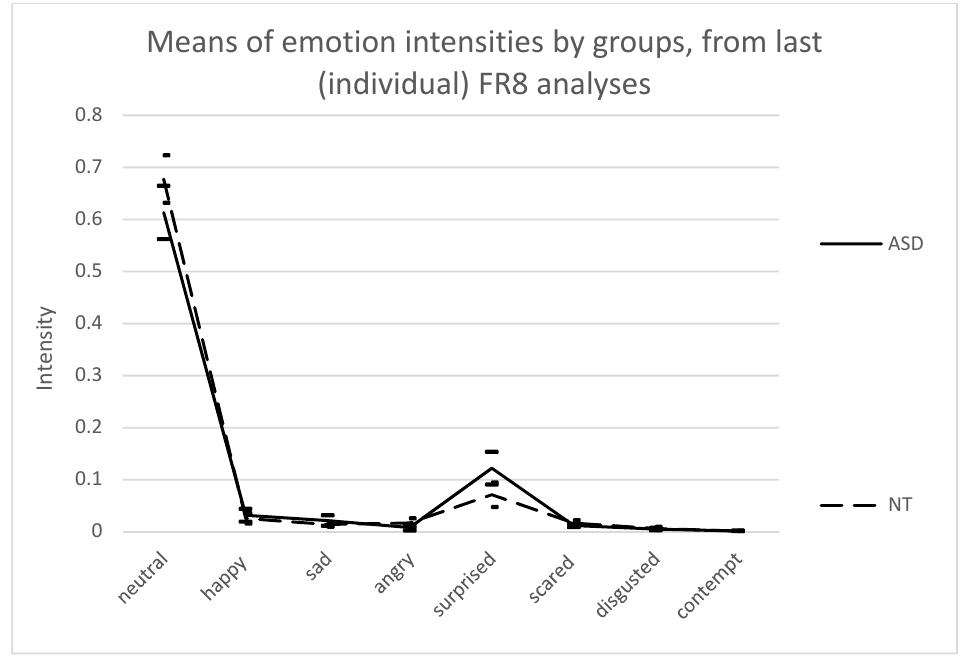
Figure 3. Group means of the intensities in the 8 emotions, by group (on data from test stable and remaining nonstable test 3 data series, n = 60). Error marks: 95% CI.